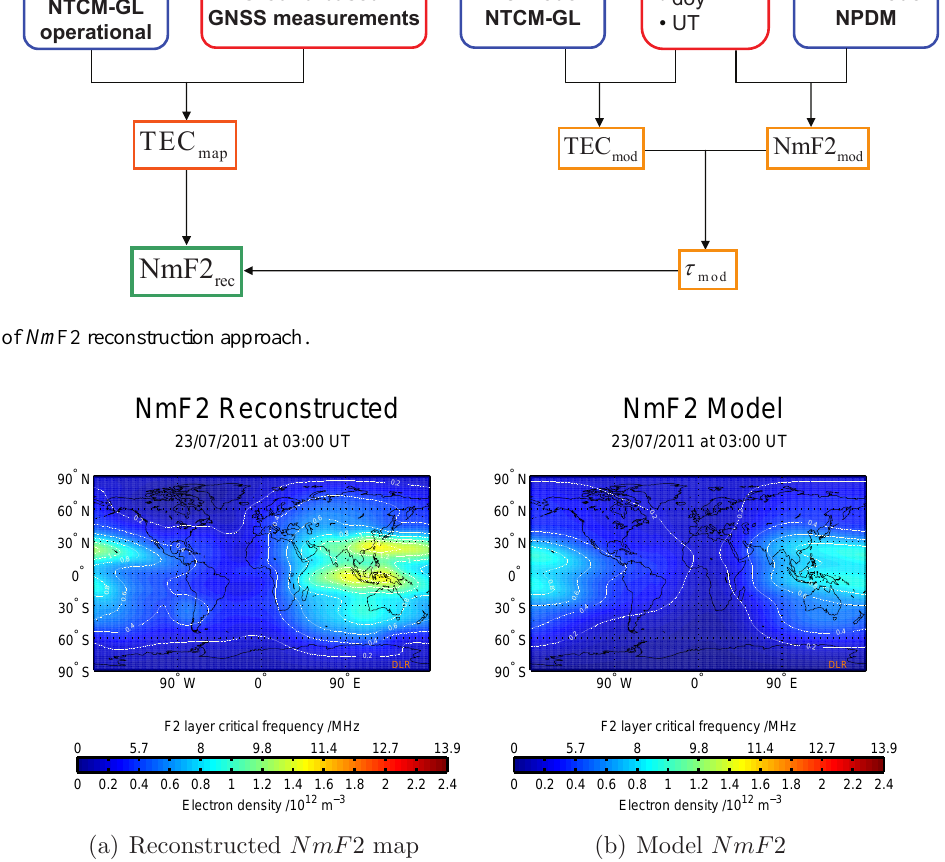
Fig. 2. Reconstructed Nm F2 rec and modeled Nm F2 mod for 23 July 2011, 03:00UT. Figure 2: Reconstructed NmF 2 and modeled NmF 2 for 23/07/2011, 03:00 UT rec mod under 0 . 2 × 10 12 m − 3 in the polar regions and locate the peaks of the ionospheric crest region around the same lo- cal time. In total the reconstruction calculates higher val- ues than the model. This is particularly noticeable for the ionospheric crest region. A detailed comparison of the recon- structed and modeled Nm F2 values with measurements from several ionosonde stations is presented in Sect.